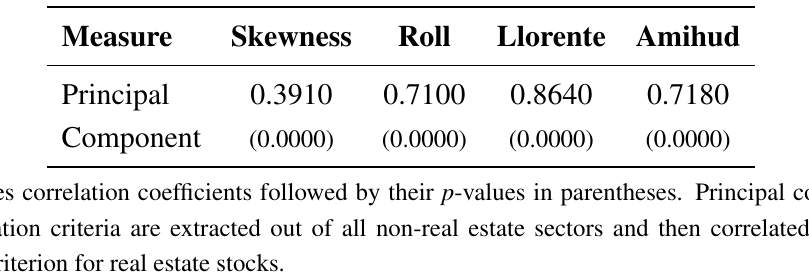
Table 5. Principal component